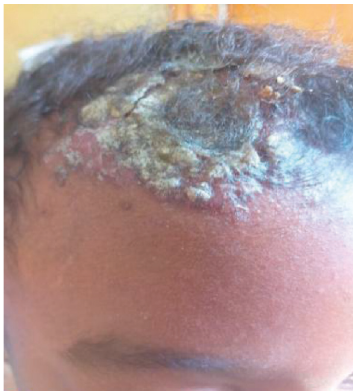
Figure 4: Yellowish-crusted plaque with indurated erythematous background on the right side of the anterior scalp and forehead, picture was taken around 9 years of age.